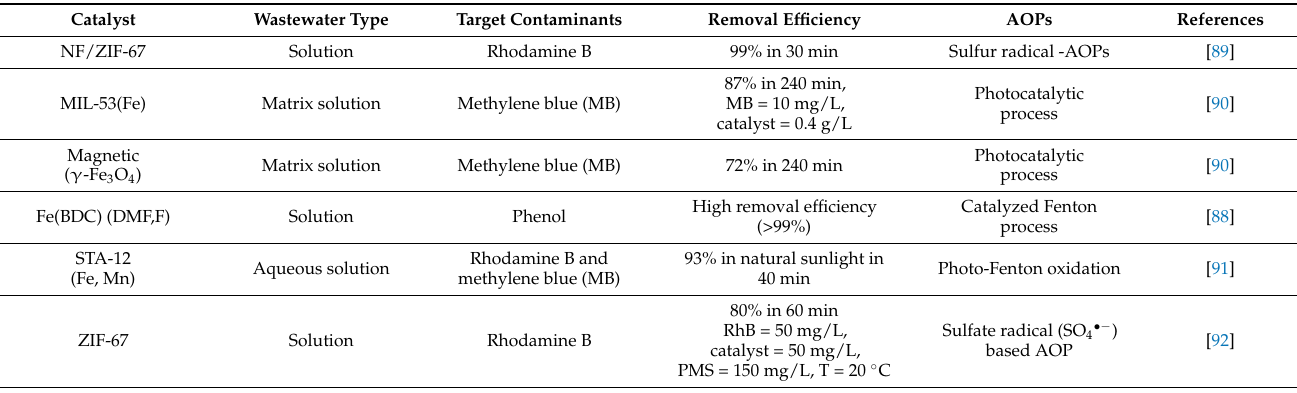
Table 8. Metal organic frameworks in AOPs for wastewater